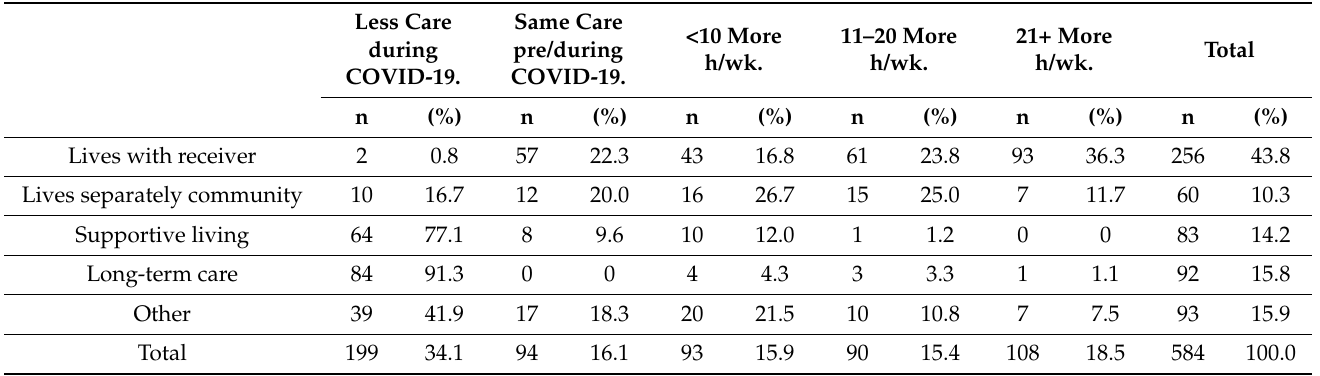
Table 3. Care hours per week (h/wk.) by care receiver’s living situation during the COVID-19 pandemic.